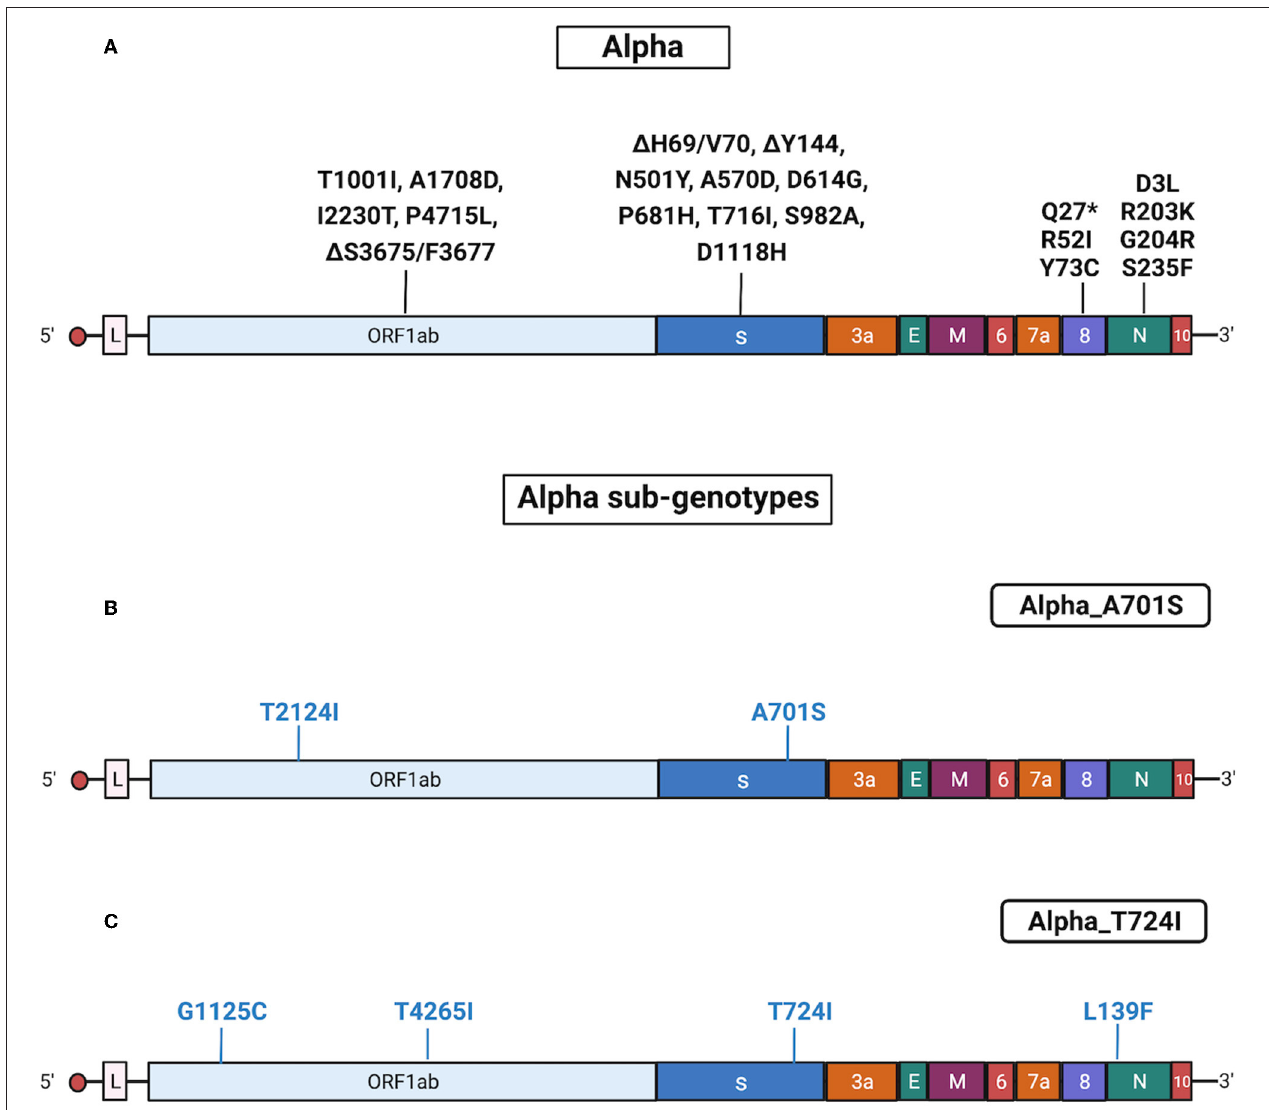
FIGURE 4 | Substitutions in Alpha isolates. The figure shows the substitutions identified in the Alpha isolates by NGS. Color code: black, substitutions common to all Alpha isolates; blue, substitutions specific for the different Alpha sub-genotypes. (A) Substitutions common to all Alpha isolates. (B) Substitutions identified in all Alpha isolates characterized by the presence of A701S (sub-genotype Alpha_A701S). (C) Substitutions identified in all Alpha isolates characterized by the presence of T724I (sub-genotype Alpha_T724I). Gene abbreviations: ORF, open reading frame; S, Spike; E, envelope; M, membrane; N, nucleocapsid. Adapted from “Genome Organization of SARS-CoV” by BioRender.com (2022). Retrieved from